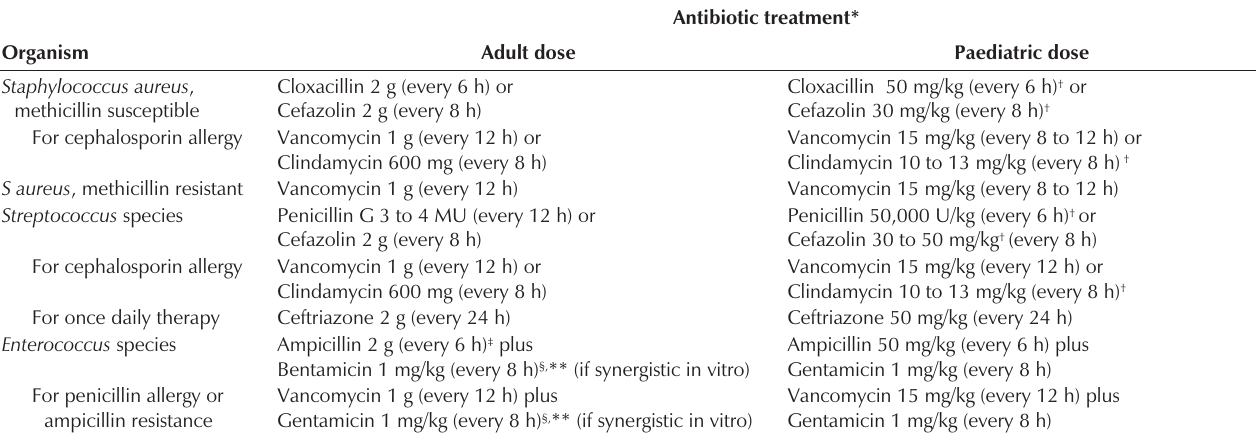
Pathogen-specific therapy: Antibiotics of choice for common Gram-positive cocci Organism